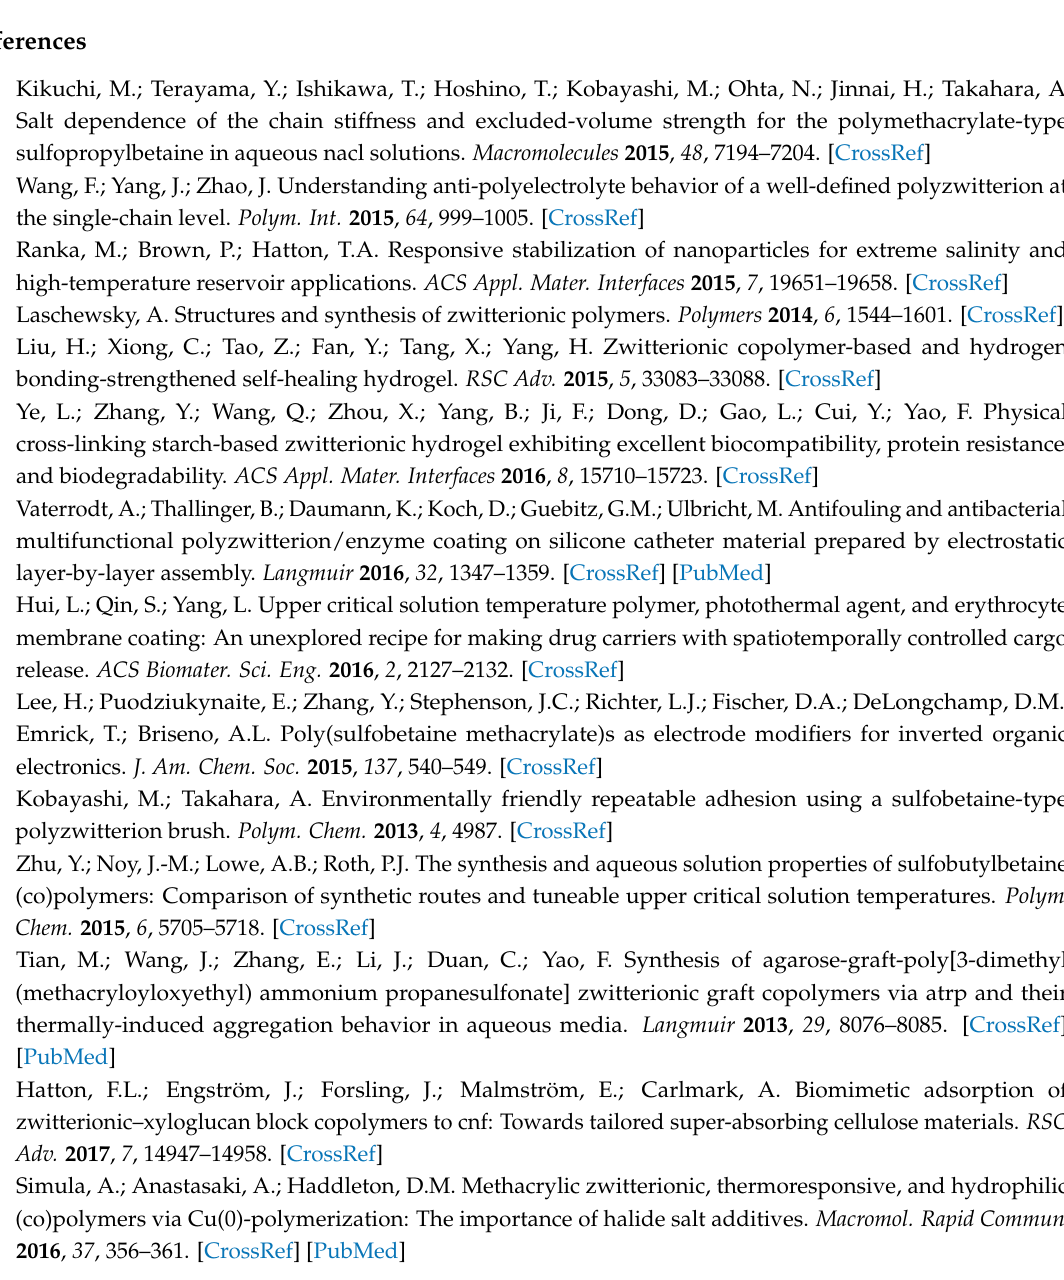
Kinetic plot of Cu 0 -mediated LRP of SBMA with target DP of 600, Figure S8: Kinetic plot of Cu 0 -mediated LRP of SBMA with target DP of 600, Figure S9: FT-IR spectrum of Starch-g-PSBMA, Figure S10: 1 H-NMR spectrum of Starch-g-PSBMA, Figure S11: Kinetic plot for the synthesis of St-g-PSBMA with target DP of 200, Figure S12: Kinetic plot for the synthesis of St-g-PSBMA with target DP of